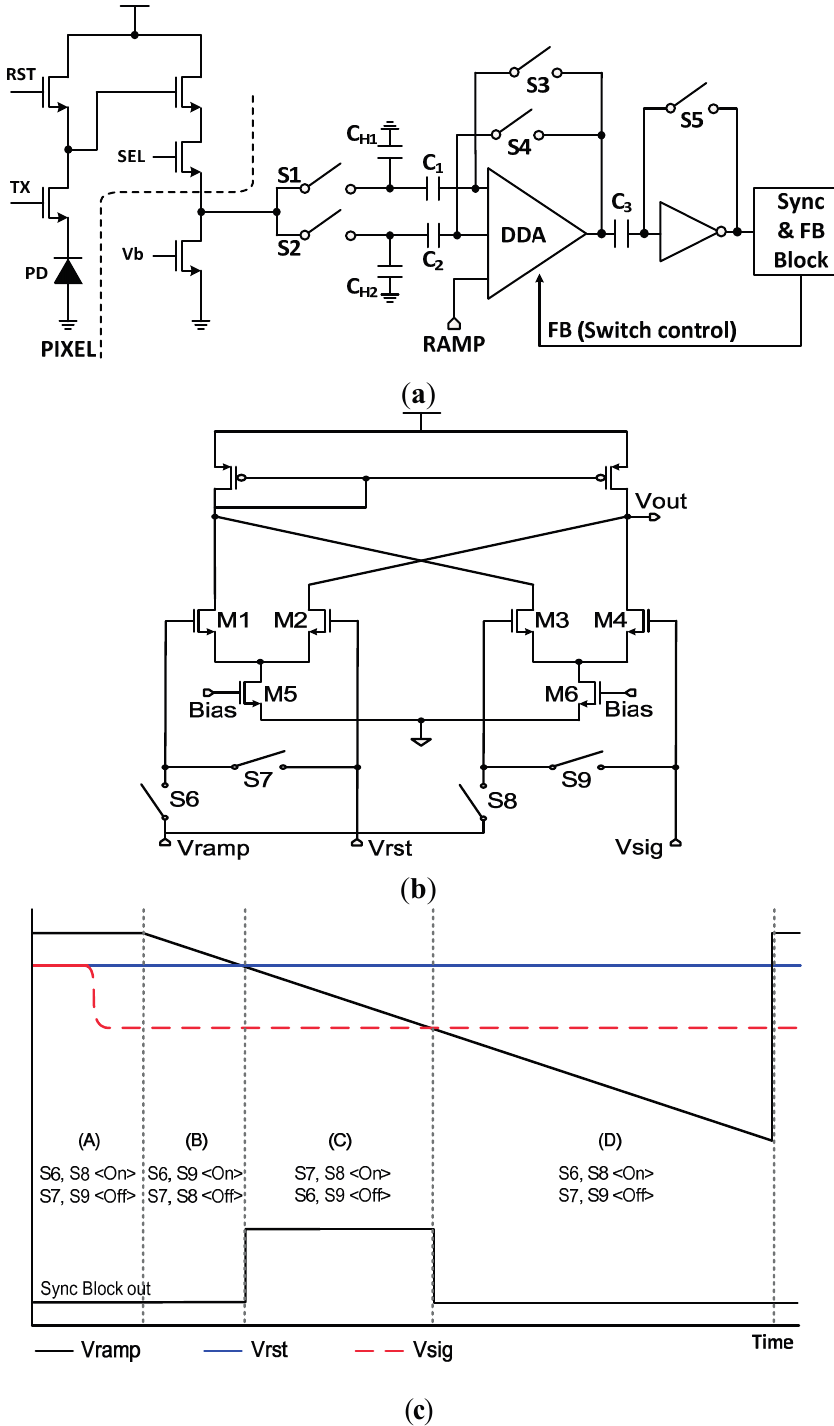
Figure 3. Principle of a SS-ADC with the novel digital CDS: ( a ) circuit diagram of a SS-ADC with the digital CDS; ( b ) circuit diagram of a differential difference amplifier (DDA); ( c ) timing diagram of a SS-ADC with the digital